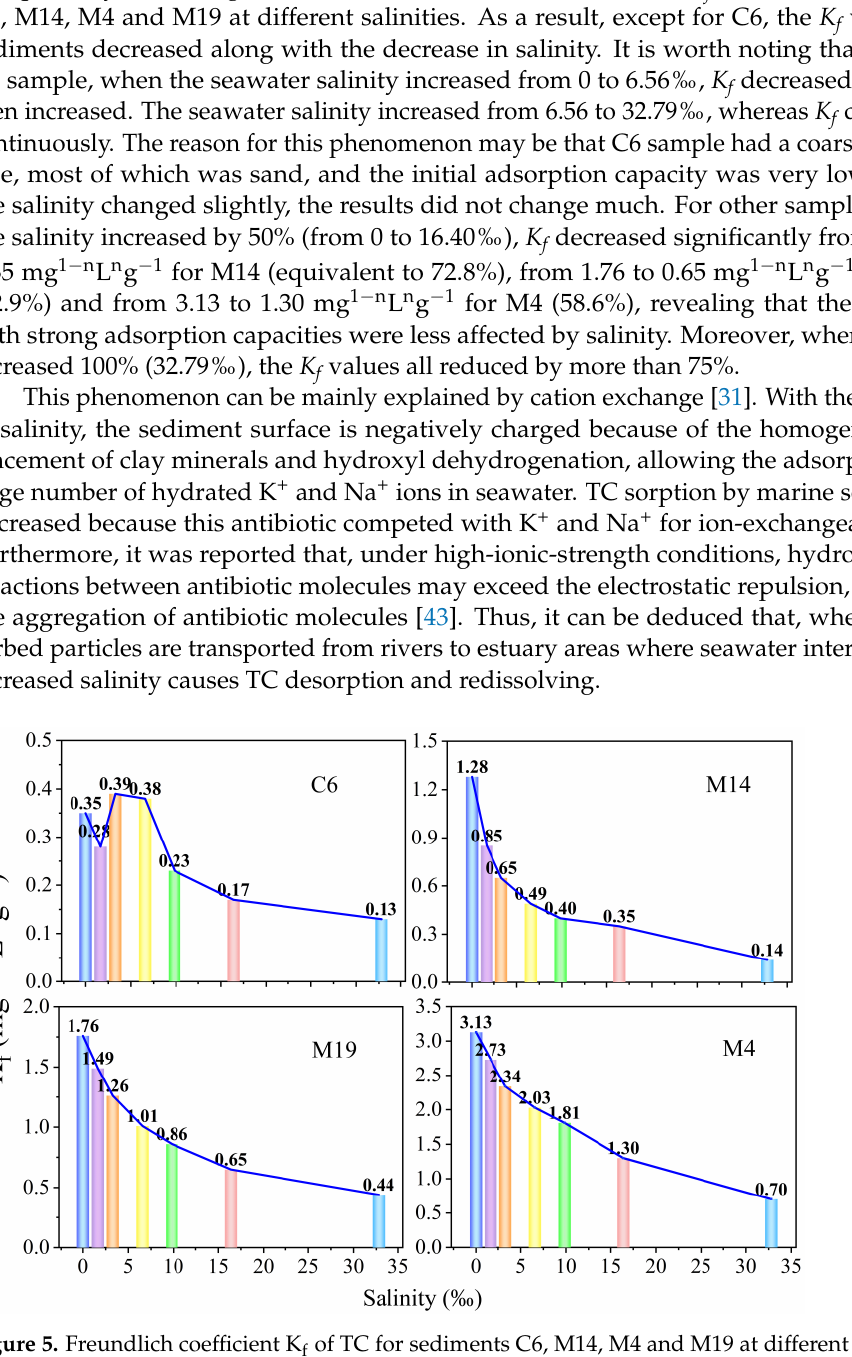
Figure 5. Freundlich coefficient K f of TC for sediments C6, M14, M4 and M19 at different salinities.